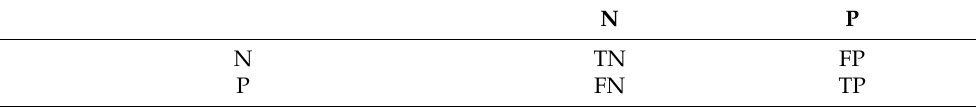
Table 2. Confusion